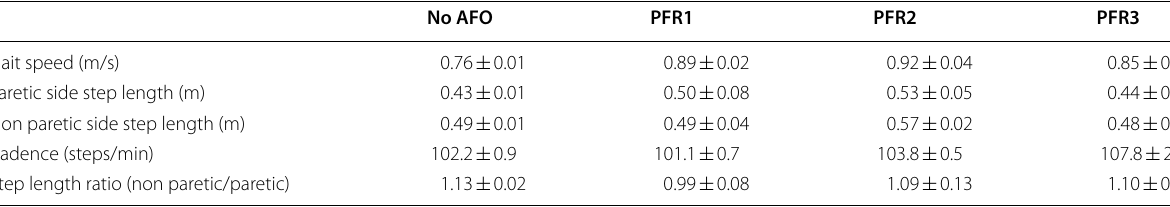
Table 2 Spatiotemporal parameters